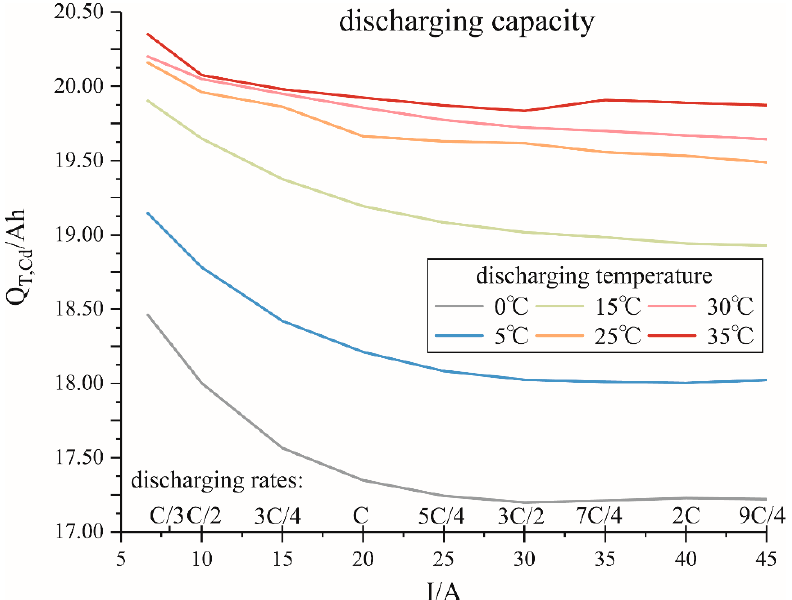
Figure 4. Evolution of the discharging capacity as a function of rate at different temperatures in the range 0–35 °C.